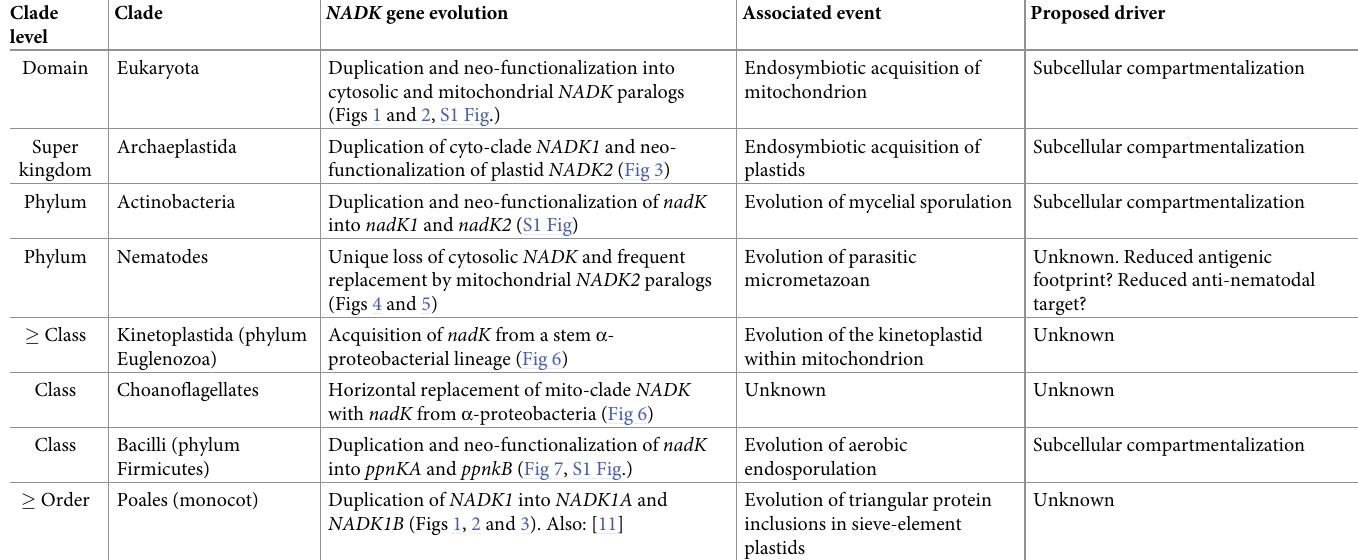
Table 1. Episodic NADK duplications associated with clade-defining evolutionary transitions. Rows are ordered from highest to lowest clade levels. Gene duplications identified in a single species are not shown